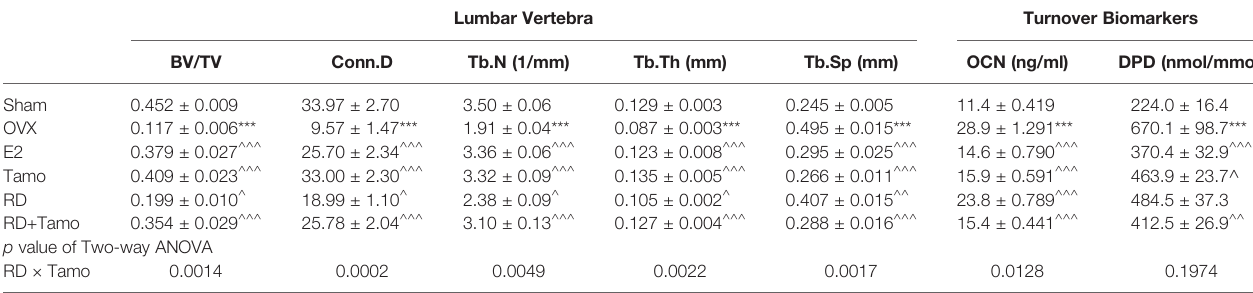
TABLE 1 | The effect of RD, tamoxifen, or their combination on trabecular bone properties and bone turnover markers in mature ovariectomized rats. Lumbar Vertebra Turnover